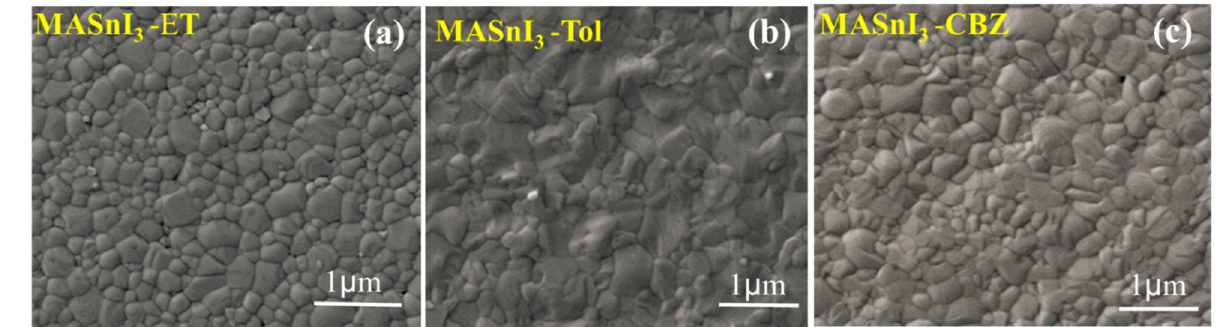
Figure 2. SEM images of MASnI 3 films treated with ( a ) diethyl ether, ( b ) toluene, ( c ) chlorobenzene.